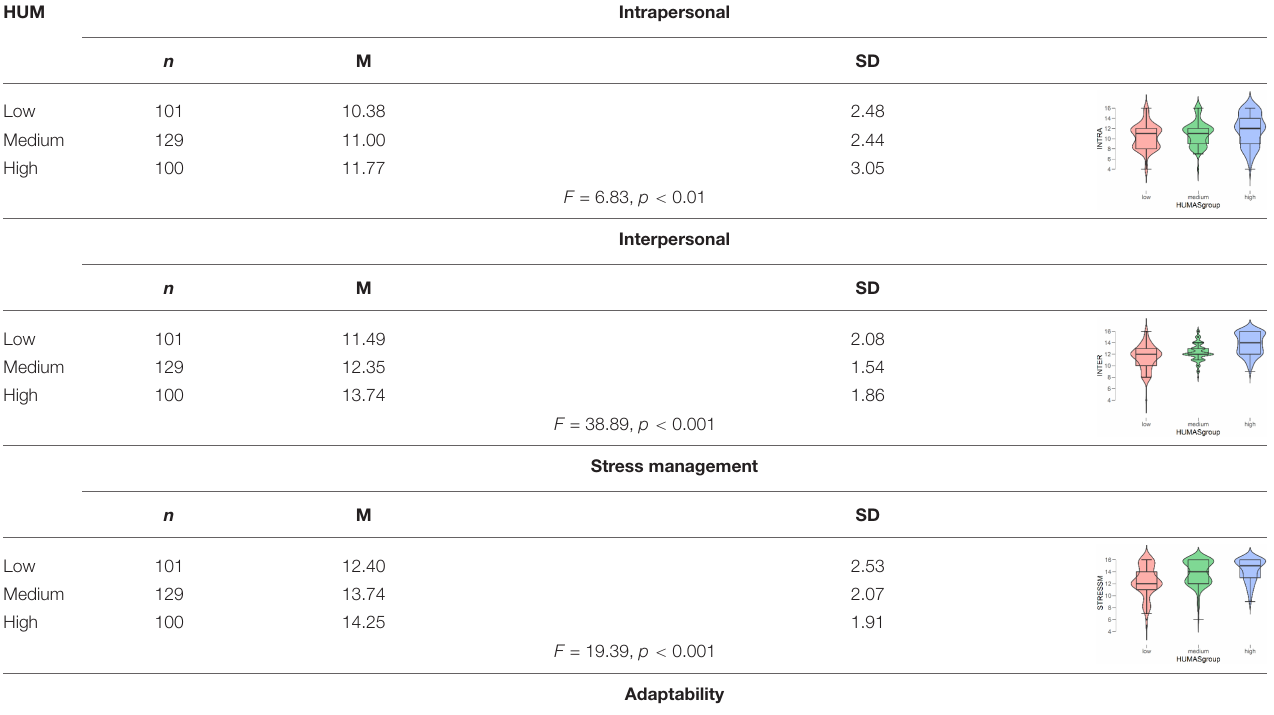
TABLE 2 | Emotional intelligence and empathy by humanization level.